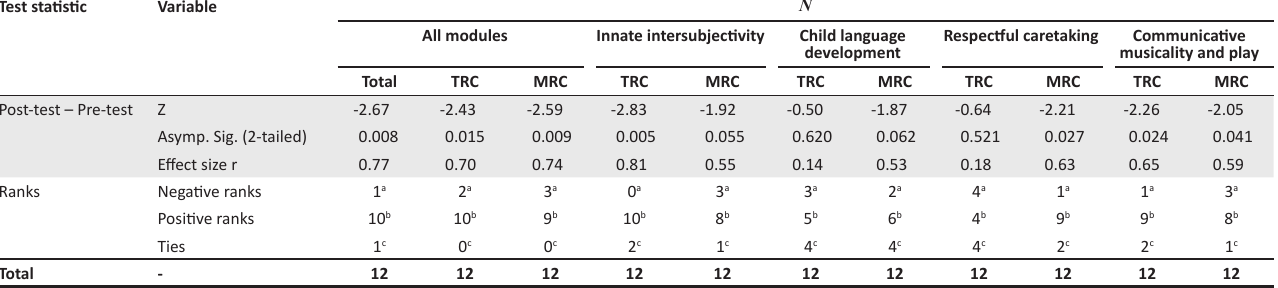
TABLE 4: Results of the Wilcoxon signed-rank test: Theoretical relational competency and methodological relational competency of all modules in total and of each module separately. Test statistic